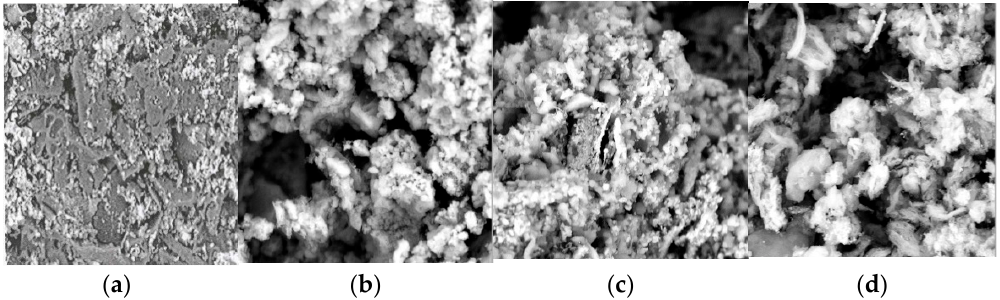
Figure 2. SEM Analysis Result of Carbonized Pre-treated Waste Samples at 15 kV × 8000 Magnification. ( a ) Carbonized HR; ( b ) Carbonized FL; ( c ) Carbonized CS; ( d ) Carbonized